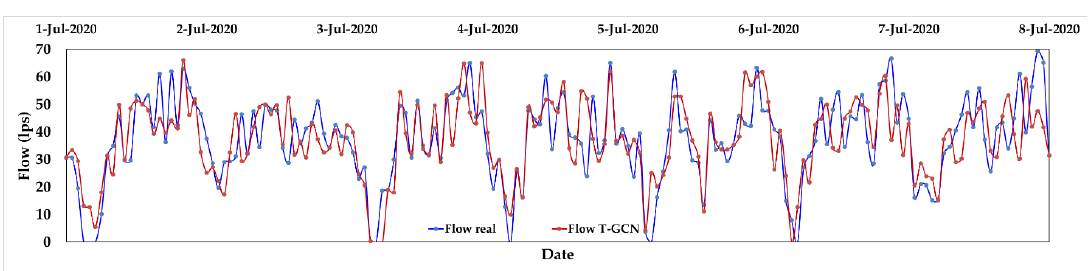
Figure 9. Comparison between estimated flow based on real and estimated relative pump speed.